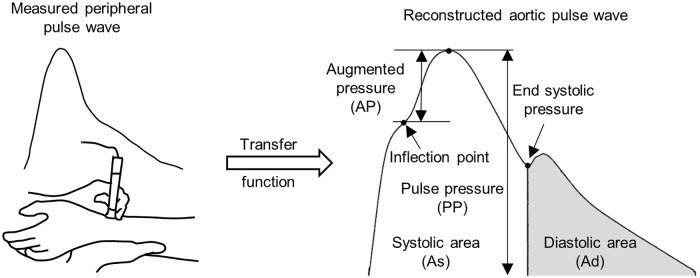
Pulse wave analysis technique.Non-invasive pulse wave recording in peripheral artery is used to synthesize the aortic pressure wave using a generalized transfer function. Characteristic points in the aortic pressure waveform are then used to calculate various indices related to the cardiovascular system state.